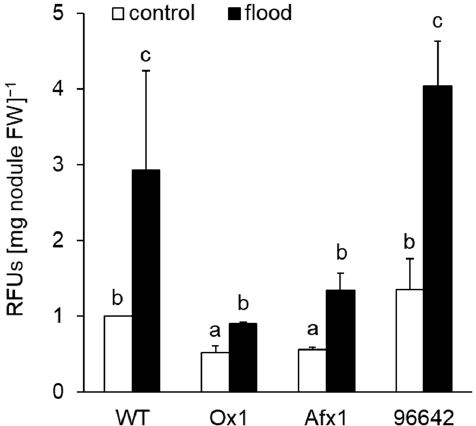
Figure 2. Quantification of NO released from nodules with the DAF-FM probe. Values are means ± SE of nine biological replicates. Means denoted by the same letter do not differ significantly by Student’s t -test ( p < 0.05).